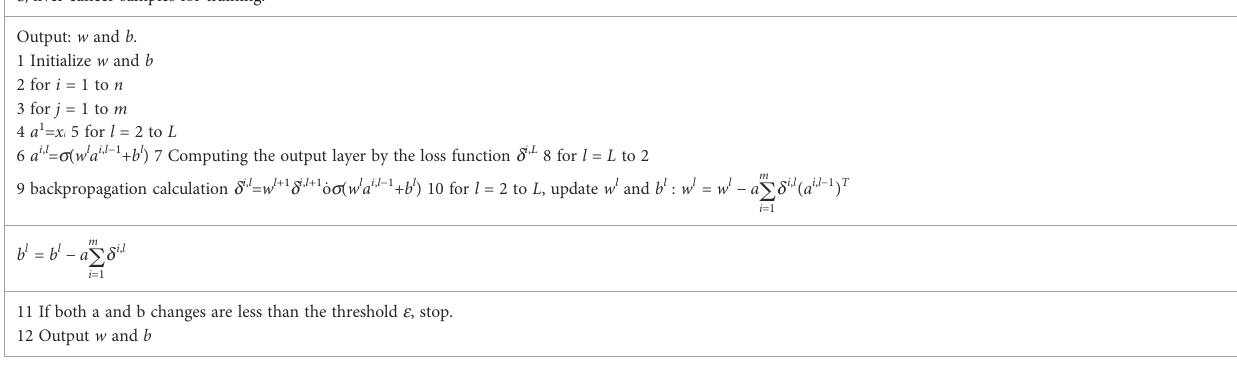
TABLE 2 Process of DNN prediction of liver cancer